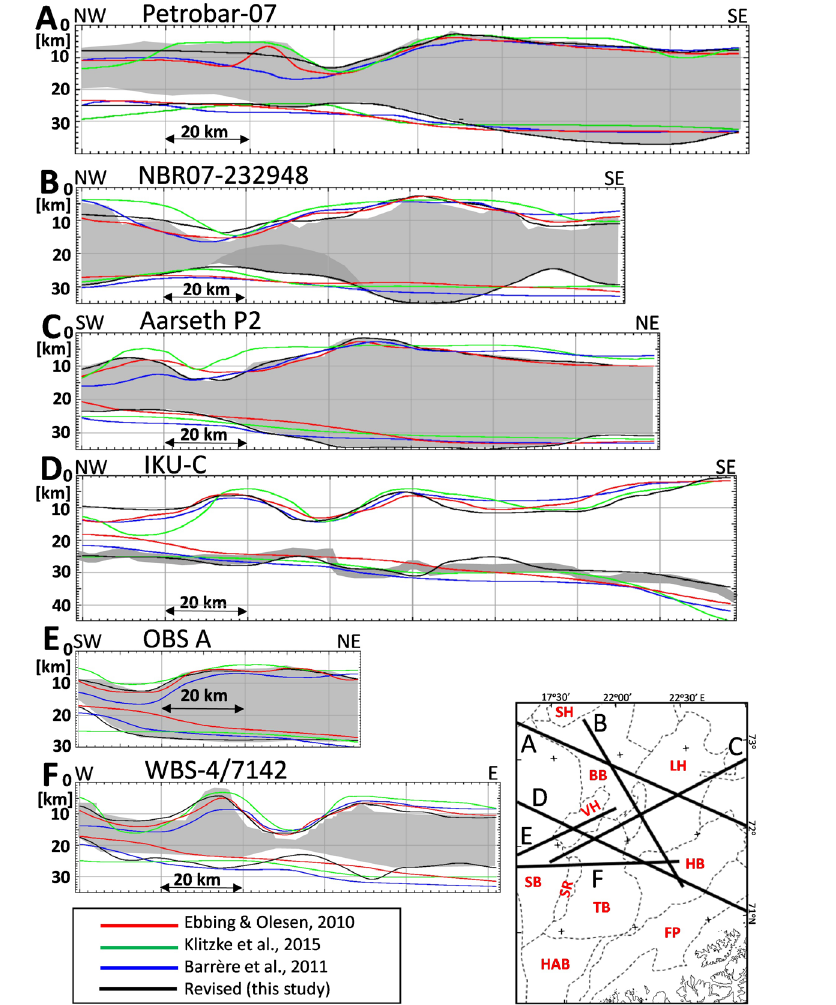
Figure 9. Comparison of published and revised top crystalline basement and Moho depths extracted along the seismic profiles, grey area is the crustal layer as defined by the seismic profiles. Profile D (IKU-C) lacked a top crystalline basement interpretation in Ritzmann and Faleide (2007). Inset with location of seismic profiles (black lines, details in Fig. 1), boundaries of structural elements (black dashed, details in Fig. 1, abbreviations in Fig.